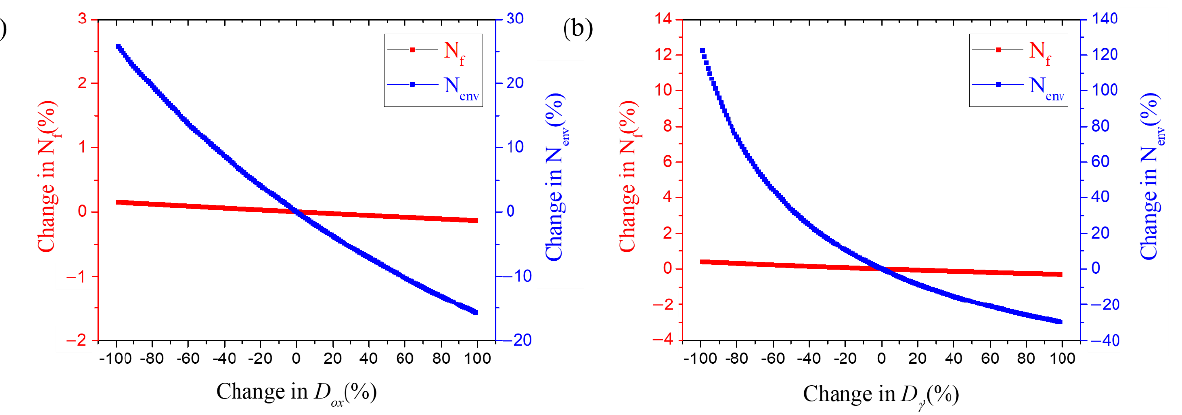
Figure 12. Fatigue life according to diffusion coefficient variable changes based on sensitivity analysis; ( a ) 𝐷 𝑜𝑥 , ( b ) 𝐷 𝛾 ′